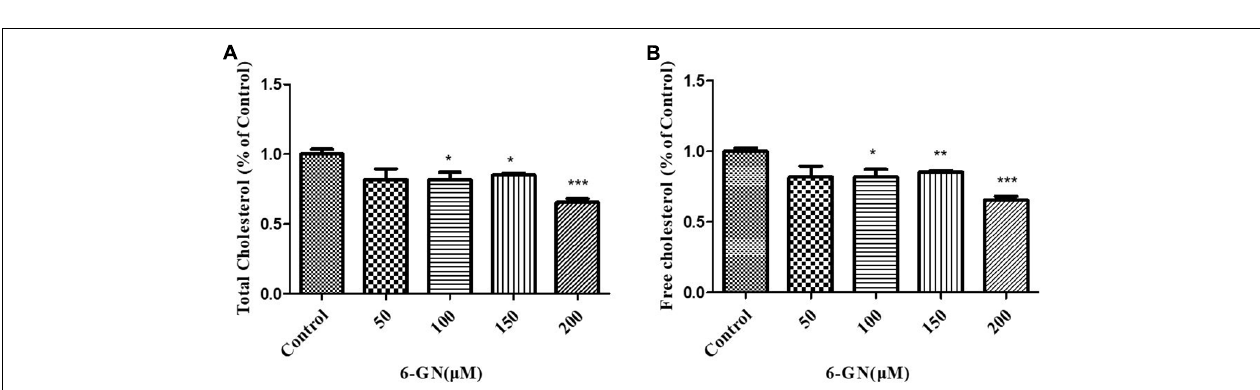
FIGURE 1 | Effect of 6-GN on cell viability ratio and cell shape in HepG2 cells. (A) Cell viability ratio of HepG2 cells disposed with or without various concentrations of 6-GN (50, 100, 200, 400, 600, and 800 µ M) for 24 h. (B) Cell shape disposed with 6-GN at the concentrations of 0 (control), 100, and 200 µ M (200 × ). Values were represented as mean + SD of three independent experiments. ∗∗∗ p < 0.001 versus control.